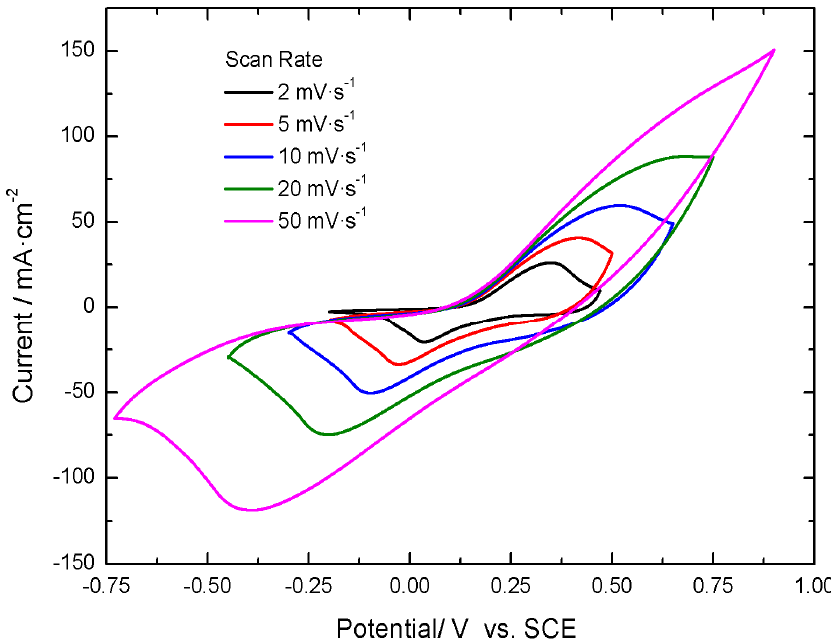
Figure 2. Cyclic voltammetry results for the positive electrode, nickel-cobalt hydroxide, at different applied scan rates.